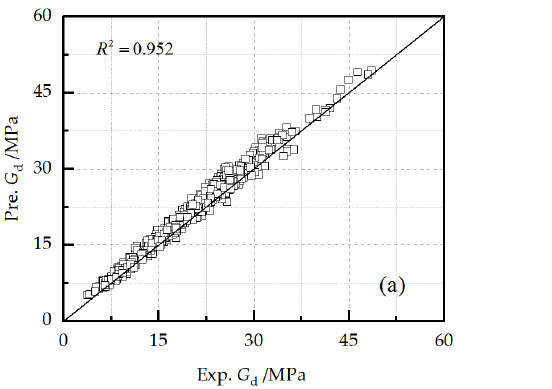
Figure 17. Prediction results (Pre.) against experimental results (Exp.) for reinforced loess: ( a ) dy- namic shear modulus, ( b ) damping ratio.